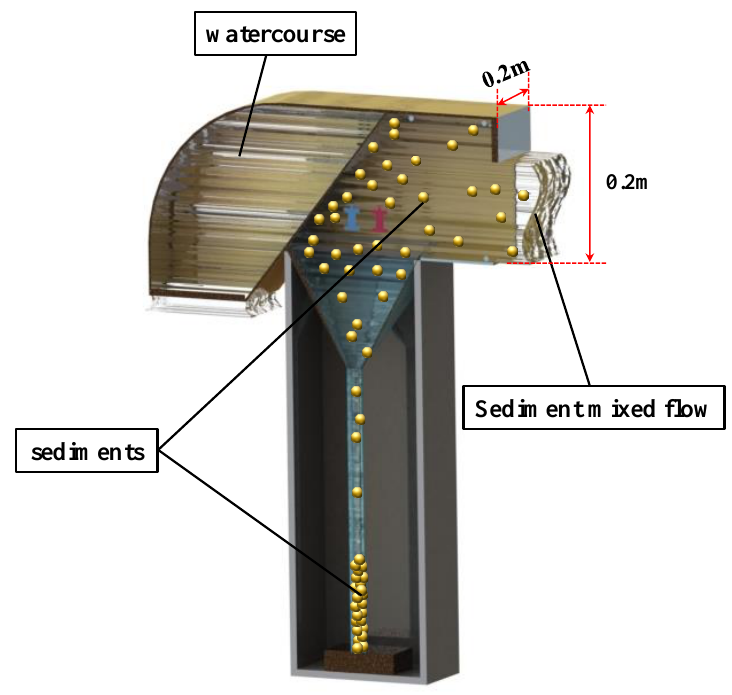
Figure 3. Working principle of the capture tube.